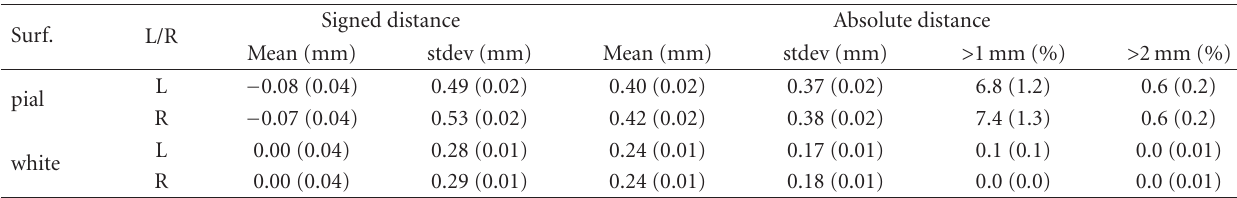
Table 2: Intermethod accuracy analysis: summary of the group-average statistics for distances between DELFMAP- and FreeSurfer-generated surfaces. Surf.